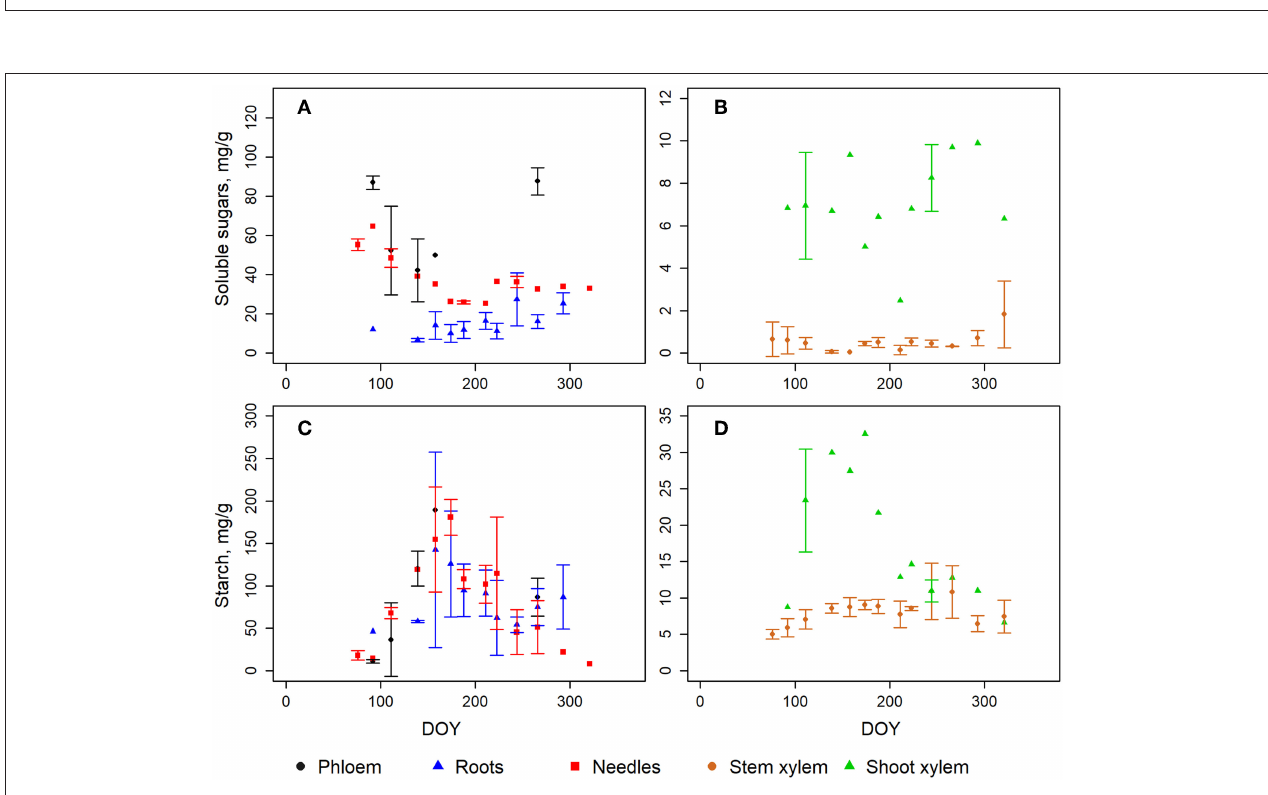
FIGURE 2 | The measured content of soluble sugars (A,B) and starch (C,D) in different tree organs. The error bars represent the standard deviation when samples from three trees were analyzed. Note different scales in y-axes. The fine roots are a mean of six samples since the concentration in the ones smaller than 1mm did not differ from those of 1–2mm. DOY represents day of year.